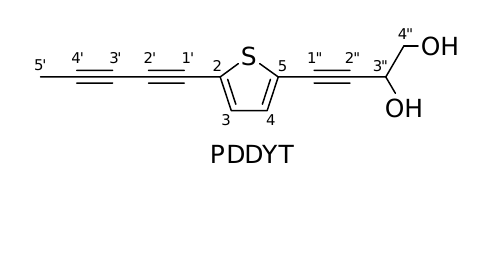
Figure 1. Chemical structure of